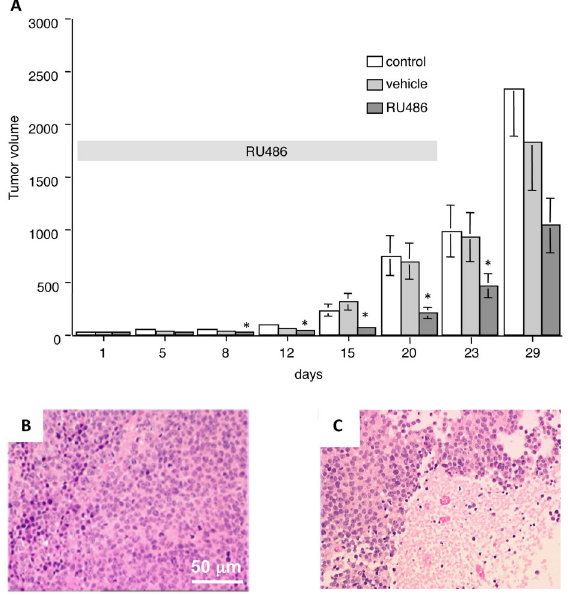
Figure 8. Effect of RU486 on the growth of the SK-N-SH cell- derived neuroblastoma xenograft in nude mice. A , Nude mice implanted with fragments of the SK-N-SH cell derived-tumors (1 mm 2 ) were treated with RU486 (15 mg/kg, two treatments/ week) from day 1 to day 20 (horizontal gray band) and sacri fi ced on day 29. The results represent the mean of three independent experiments done in triplicate. Hematoxylin-eosin staining of 10- m m sections of control ( B ) or RU486-treated ( C ) xenografted tumors (magni fi cation bar: 50 m m). Data are reported as means ± SD. *P o 0.05 vs vehicle